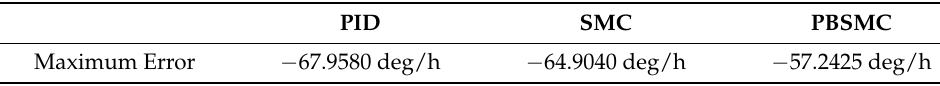
Table 8. Angular Rate Total Error Comparison.